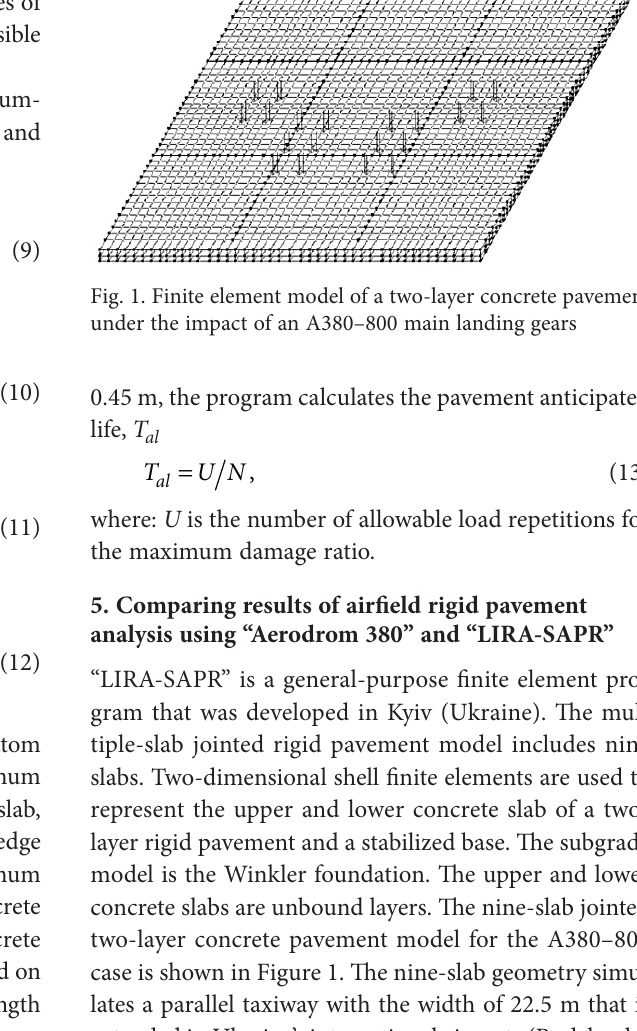
The maximum tensile stress Top to at the top and bottom of the upper slab bottom (“Aerodrom 380”), MPa ratio